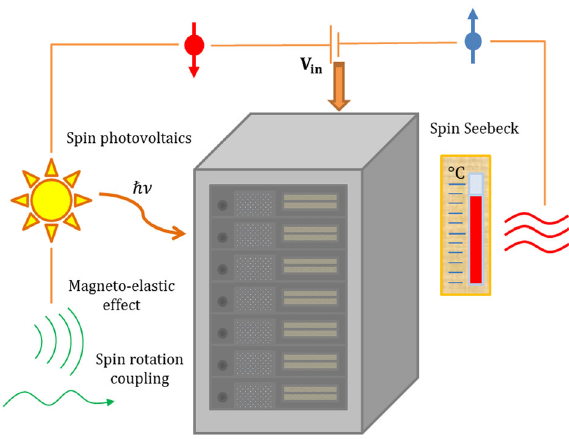
Fig. 7 Energy interconversion recti fi ed by the electron spin. Diverse spin phenomena can act as energy interconversion recti fi ers among energy sources such as heat (spin Seebeck effect), light (spin photovoltaics), sounds and vibrations (magnetoelastic effect and spin – rotation coupling). The collected energy can feedback power to servers in data